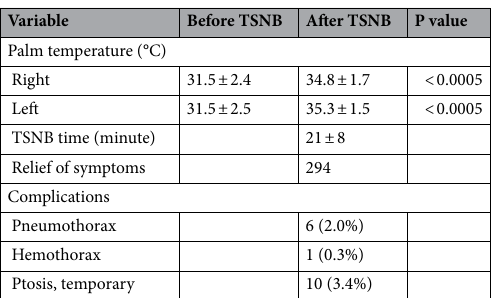
Table 2. Perioperative characteristics of patients before and after TSNB. Values are number (%) or mean ± standard deviation. TSNB thoracic sympathetic nerve